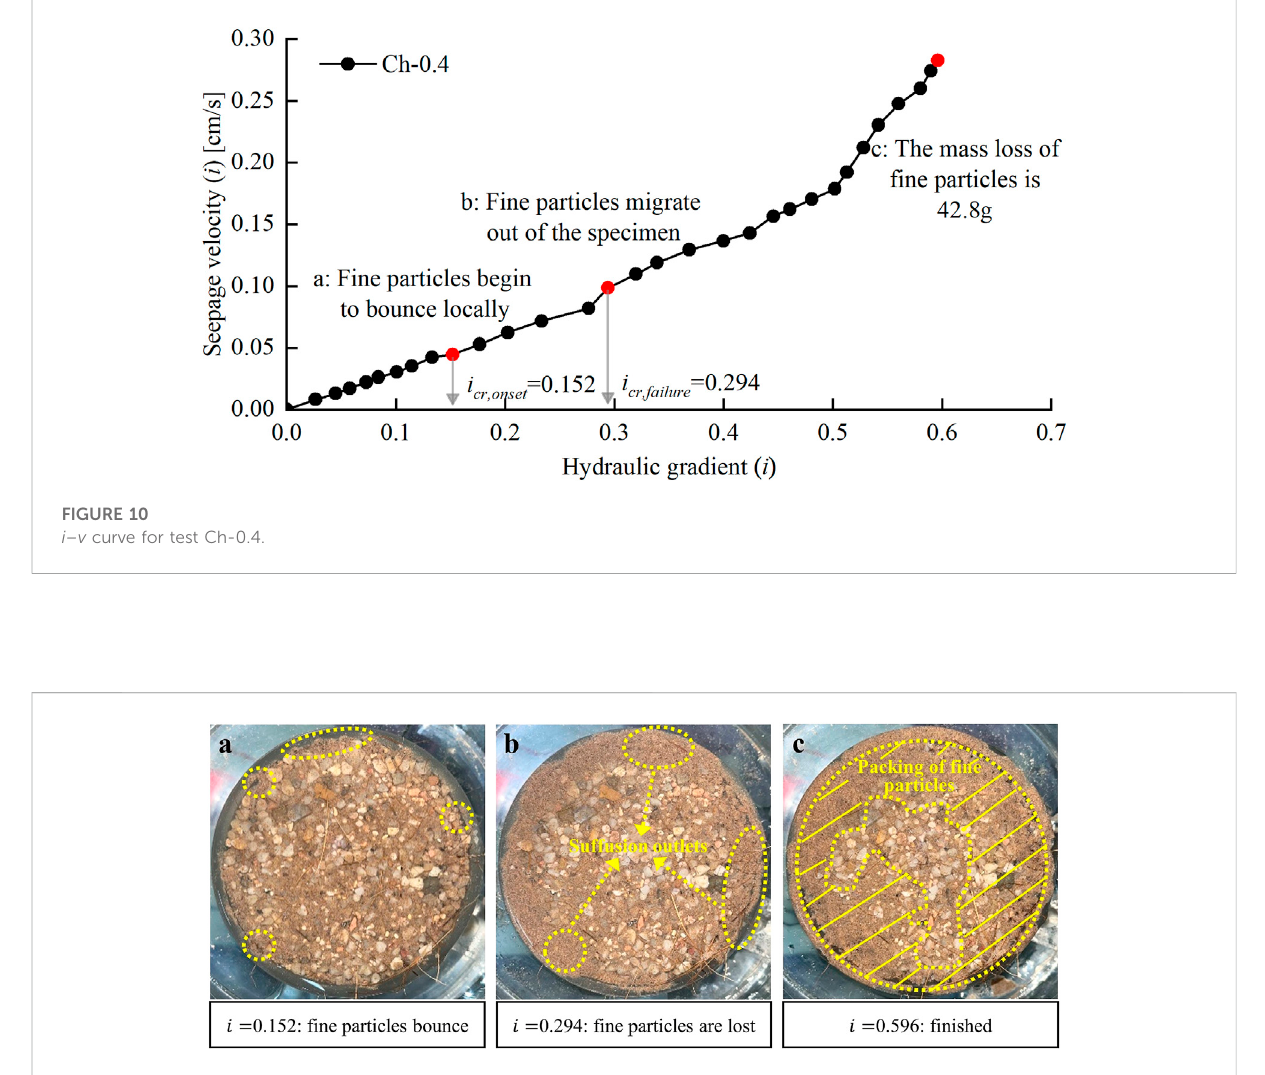
FIGURE 11 Phenomena in test Ch-0.4. (A) i = 0.512: fi ne particles bounce. (B) i = 0.294: fi ne particles are lost. (C) i = 0.596: fi nished.